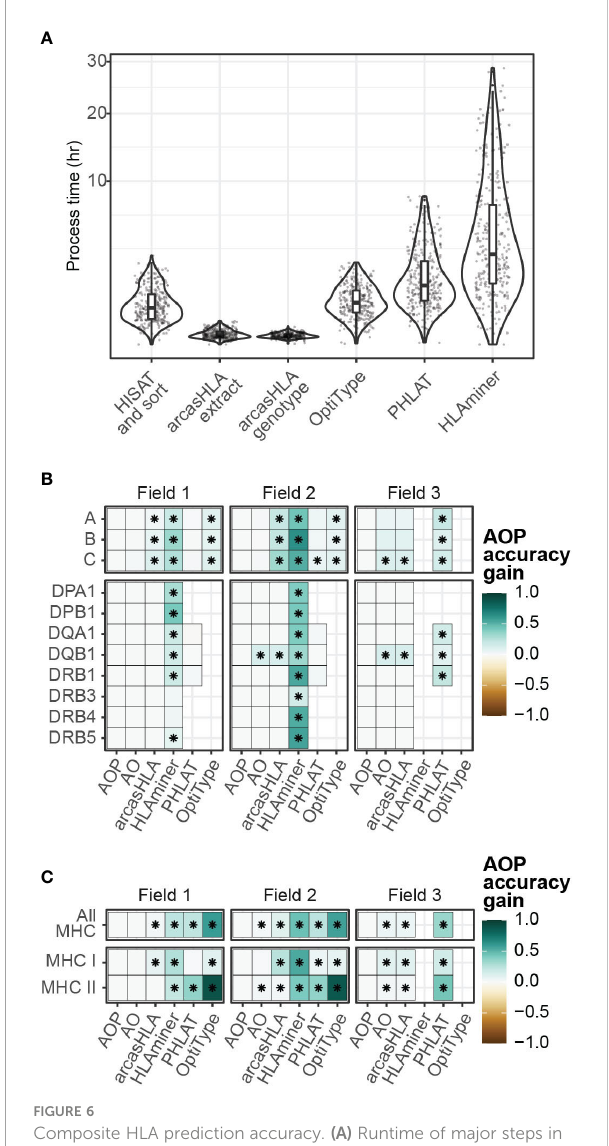
FIGURE 6 Composite HLA prediction accuracy. (A) Runtime of major steps in genotyping pipeline. Y-axis distributed along square root scale. (B, C) Difference in mean accuracy between AOP composite and indicated alternative genotyping methods across (B) individual loci and (C) loci classes. (AOP) composite of arcasHLA, OptiType, PHLAT, (AO) composite of arcasHLA, OptiType. (*) FDR-adjusted p-value ≤ 0.05 by Wilcoxon rank sum